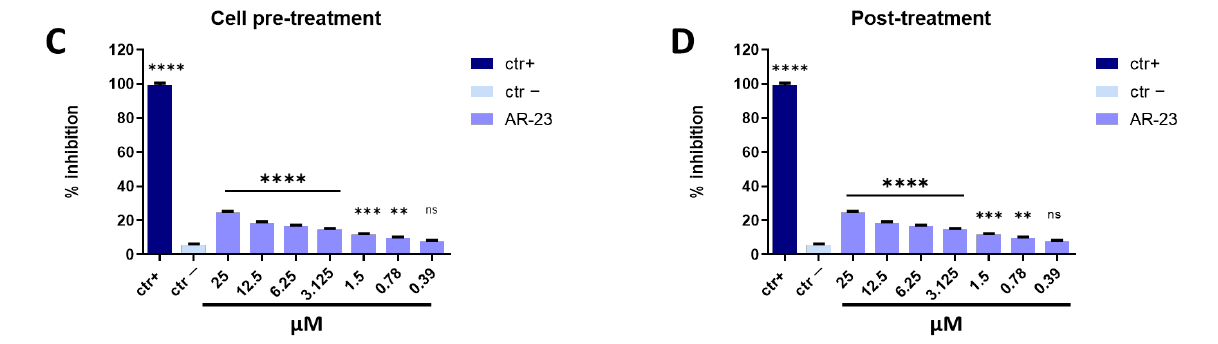
Figure 7. Antiviral activity against betacoronavirus (SARS-CoV-2). Different assays were performed in order to evaluate anti-SARS-CoV-2 activity. ( A ) Co-treatment: simultaneous addition of AR-23 and virus to the cells; ( B ) Virus pre-treatment: virus incubated with the peptide, and then used to infect cells; ( C ) Cell pre-treatment: AR-23 incubated with the cells before the viral infection; ( D ) Post-treatment: AR-23 added to the infected cells. Peptide AR-23 inhibited the early stages of infection, acting in co-treatment ( A ) and virus pre-treatment ( B ) assays, while it was not able to interact with the cellular surface ( C ) or block the viral replication ( D ). Different compounds were used as positive control (ctr+) for each treatment: rhamnolipids M15RL ( A , B , 50 μ g/mL for both the assays) [43] , ivermectin ( C , 10 μ M) [45] , and remdesivir ( D , 10 μ M) [45] , while infected cells were used as negative control (ctr-). **** p < 0.0001; *** p < 0.0002; ** p < 0.0021; * p < 0.021; ns: non-significant.